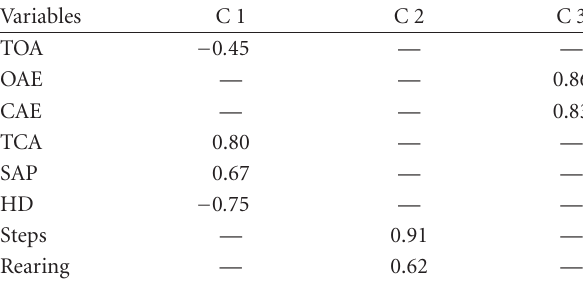
Table 1: Rotated component patterns for experiment 1 (plus-maze and staircase). TOA = time spent in open arms; OAE = number of entries to open arms; CAE = number of entries to closed arms; TCA = time spent on the central area; SAP = stretched-attend posture; HD = unprotected head dipping (HD); steps = number of steps climbed; rearing = number of rearings. Only component patterns above 0.40 were recorded.